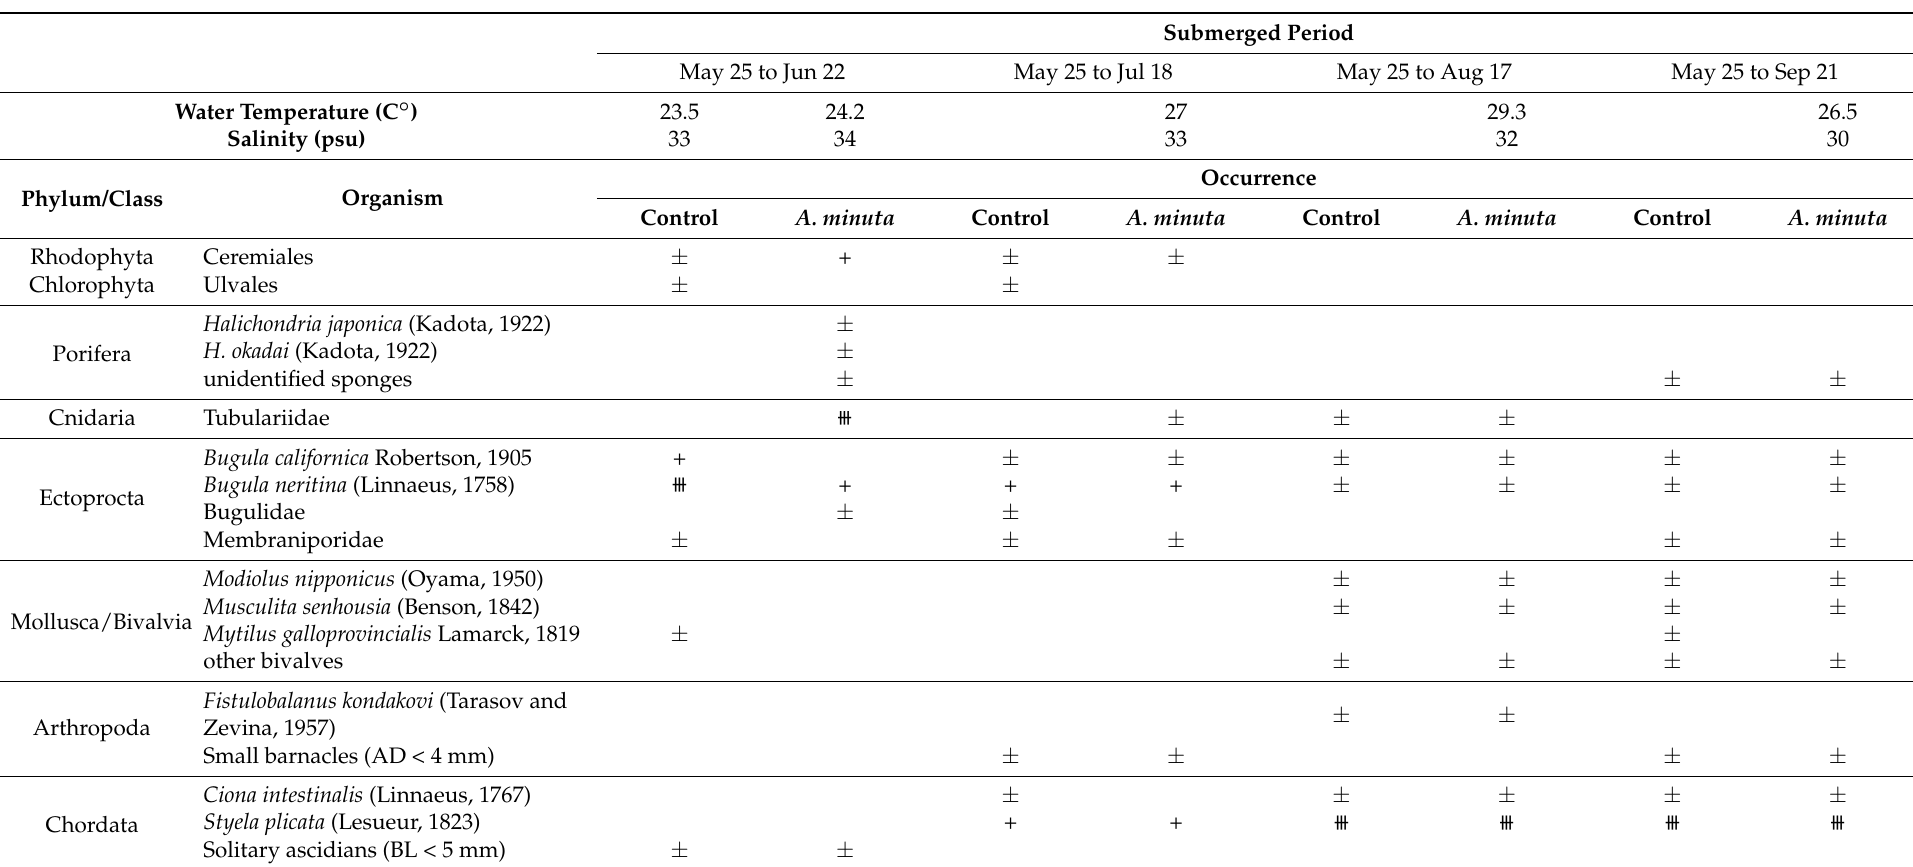
Table 2. Water temperature and salinity of the test site, and occurrence of attaching organisms on the control and A. minuta collectors during the test period.